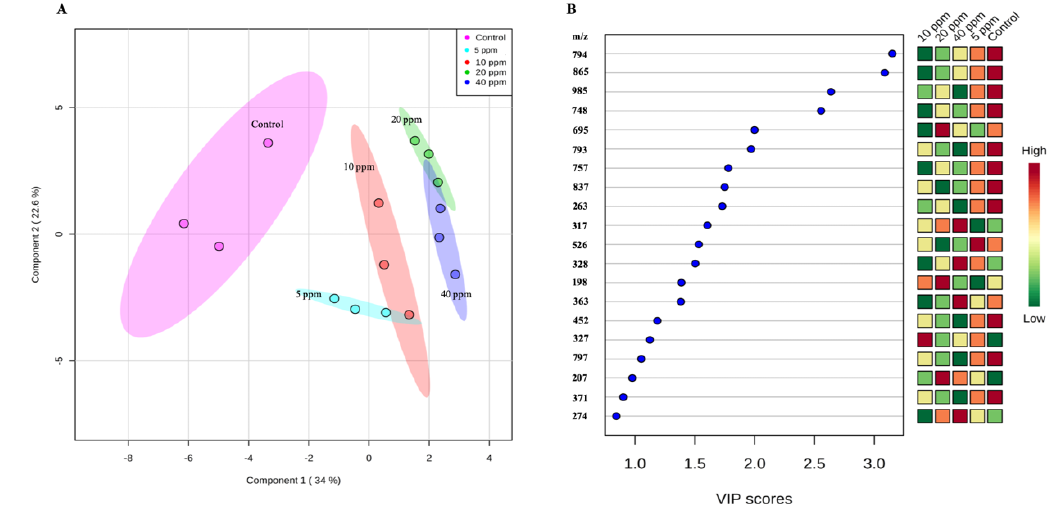
Figure 1. Partial least squares discriminant analysis (PLS-DA) of metabolites in oligochitosan O-80-treated white radish sprouts (WRS) samples (0 (control), 5, 10, 20 and 40 ppm) analyzed by LC-MS in the positive ion mode. Each spot represents a biological replicate ( A ). Variable in projection (VIP) scores of the top 20 metabolites ( B) .